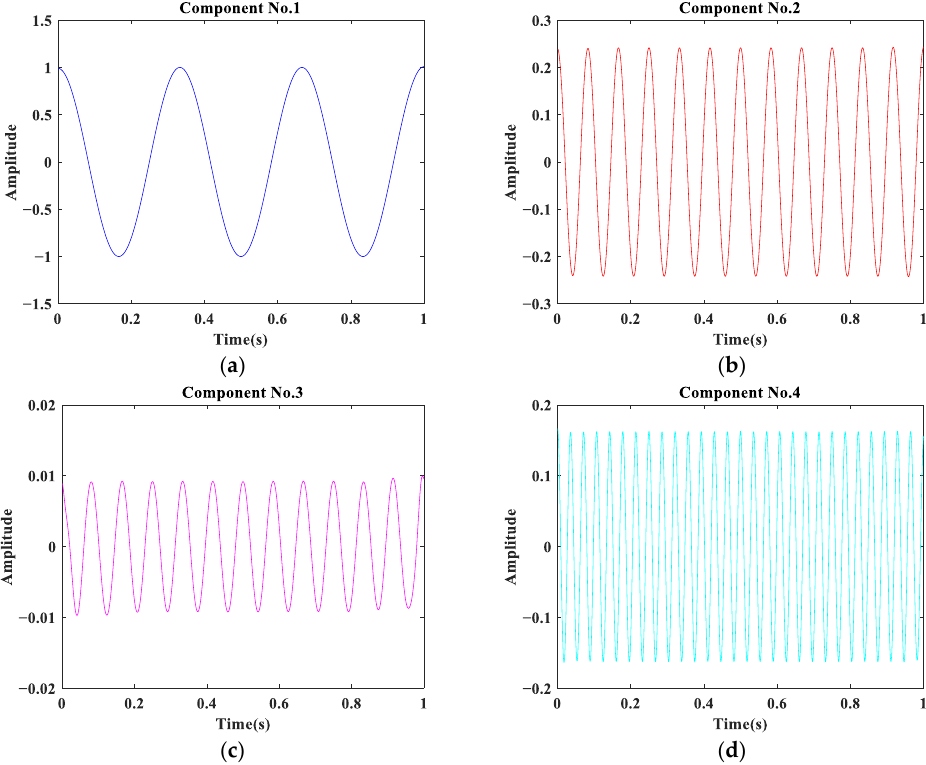
Figure A3. The decomposition result by VMD when K = 3 and α = 2500. ( a ) The original signal; ( b ) No.1 mode component; ( c ) No.2 mode component; ( d ) No.3 mode component.